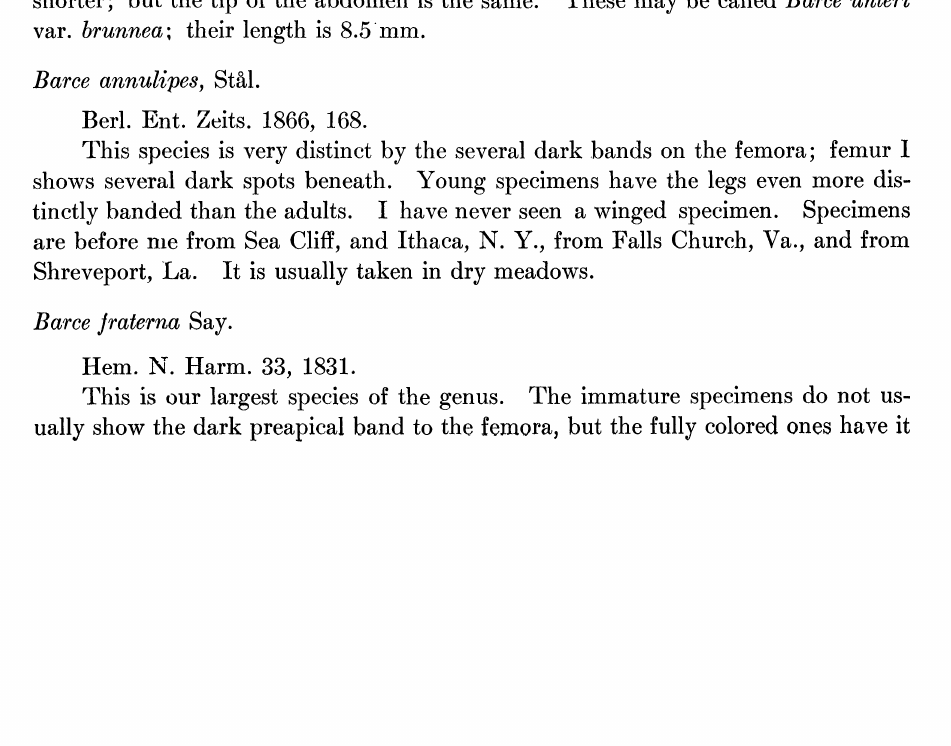
Fig. 1.--Barce uhleri, last abdominal seg- ment, of mule und